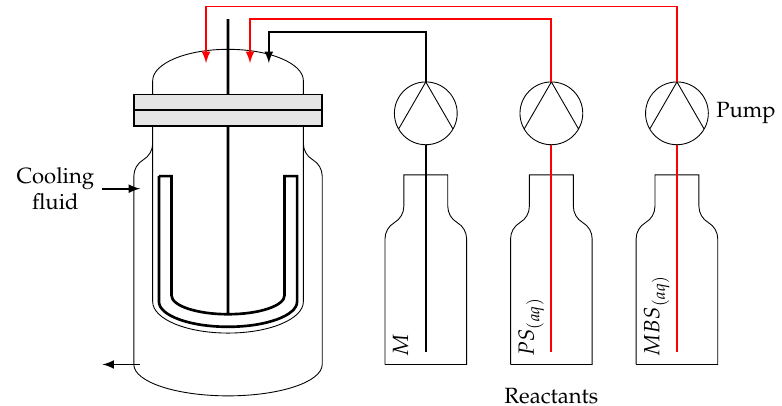
Figure 1. Laboratory SBR scheme. Jacketed reactor equipped with three pumps for the feed of pure monomer and aqueous solutions of PS and MBS.